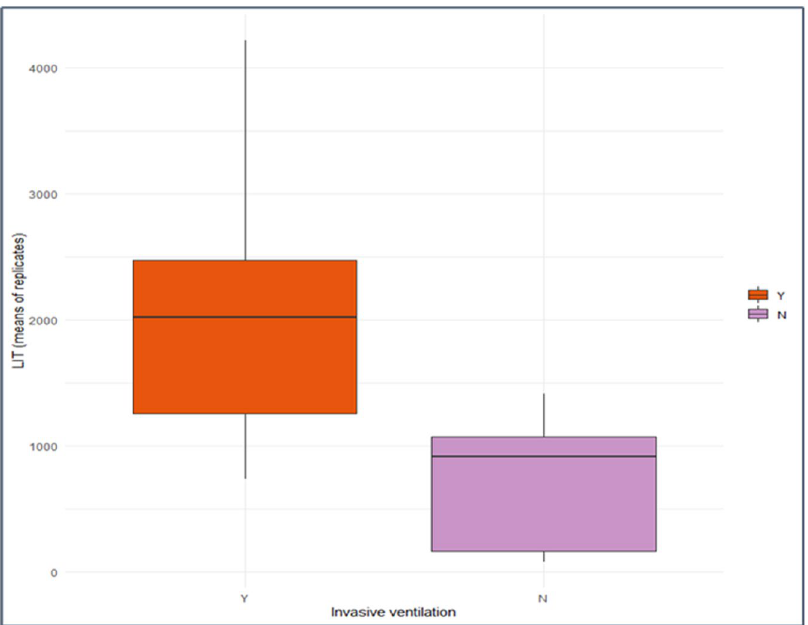
Figure 2. Box plots showing distribution of LIT scores in patients with COVID-19 in relation to invasive ventilation status. Horizontal lines in each box represent the median LIT scores for each cohort. Median LIT score for patients on invasive ventilation was 2020 and compared with 916 for those not on invasive ventilation (Mann Whitney U test: p =